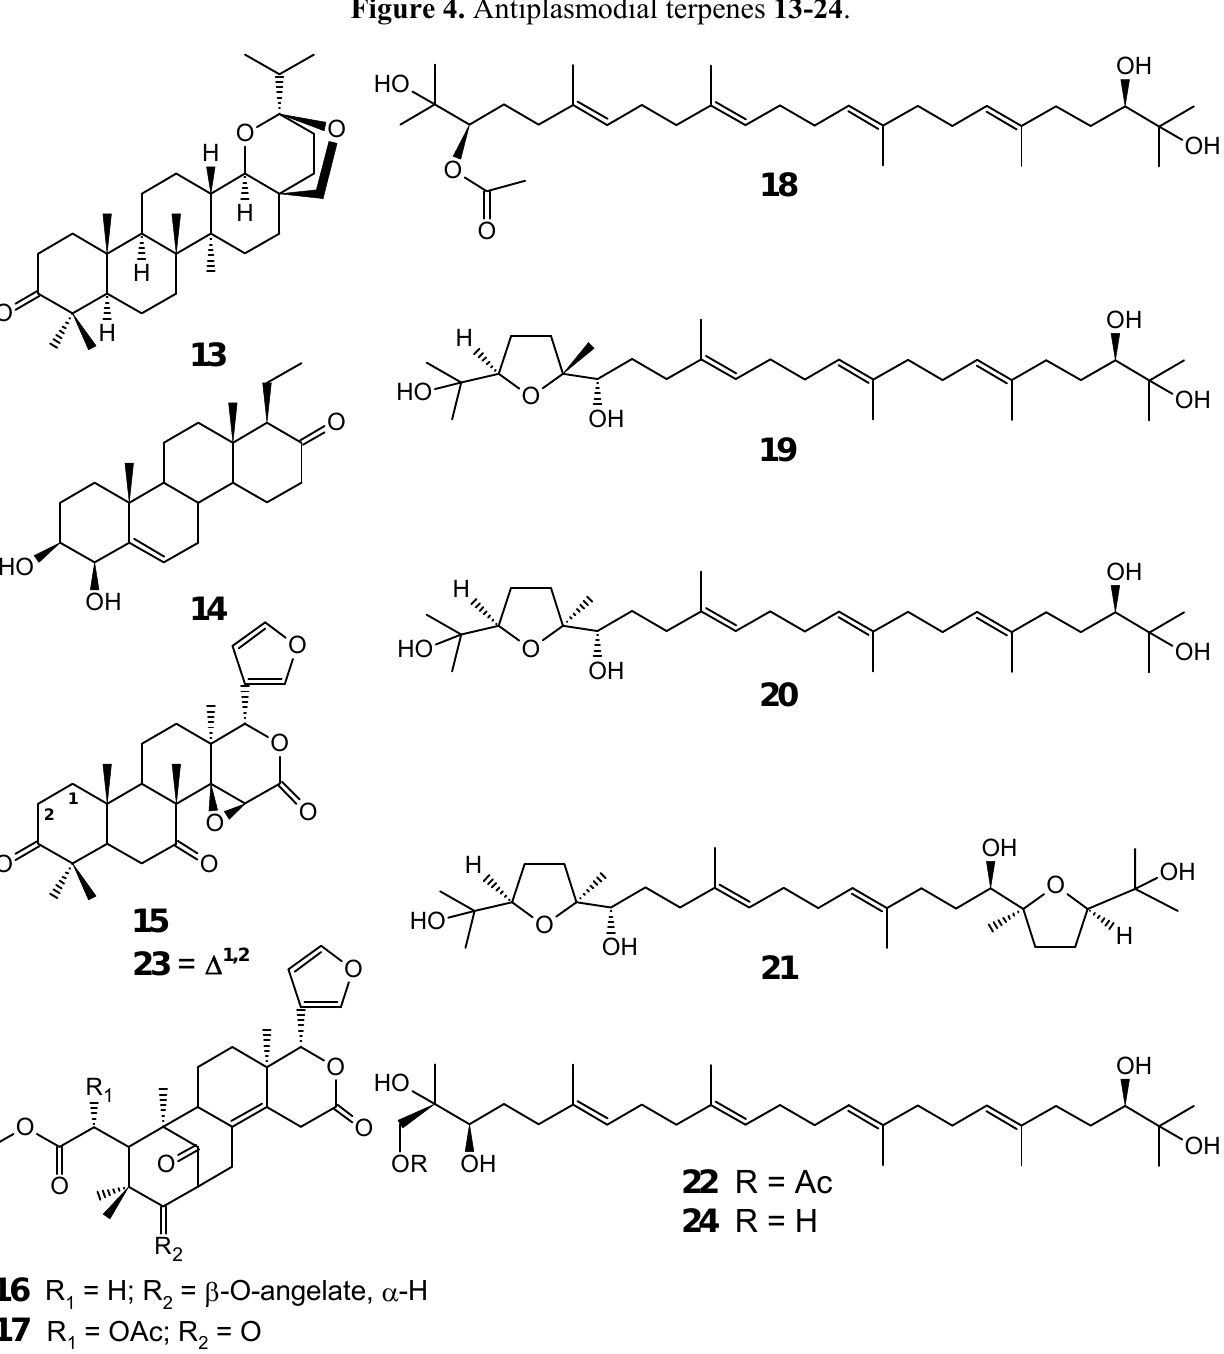
Figure 4. Antiplasmodial terpenes 13-24